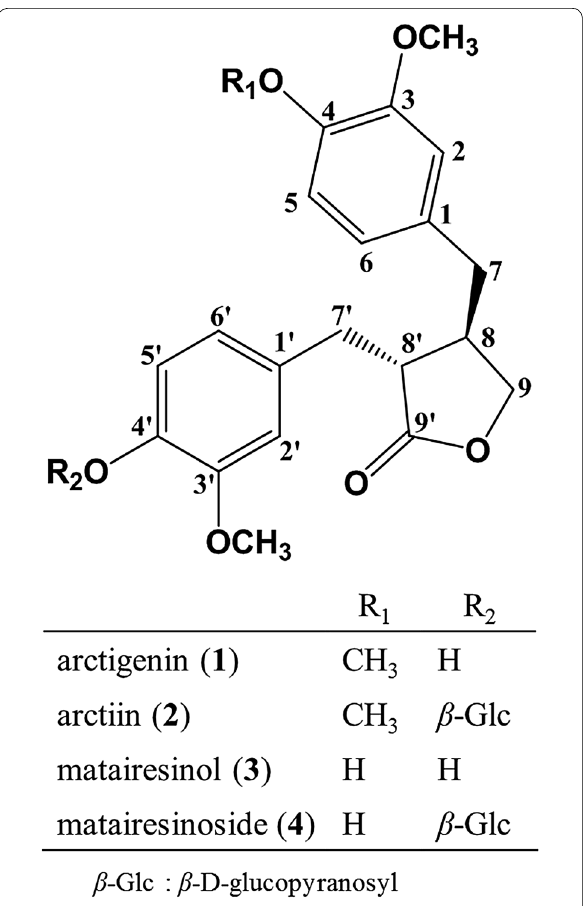
Fig. 1 Molecular structures of lignans in Forsythia koreana